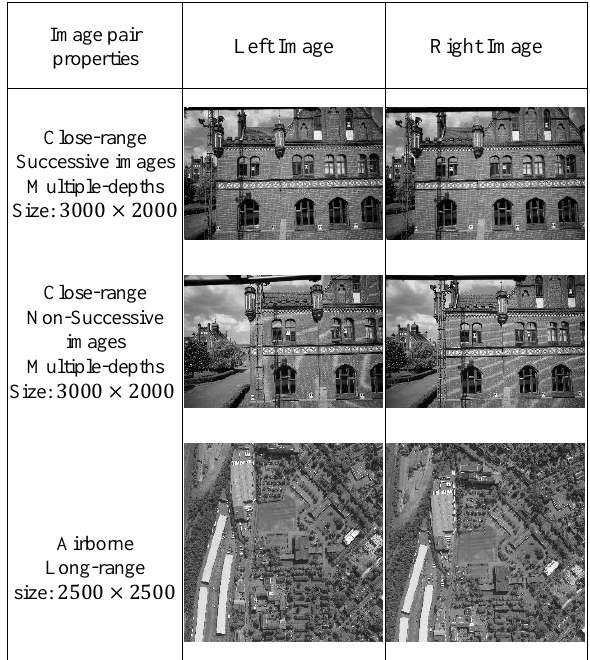
Table 1. Dataset from ISPRS and EuroSDR